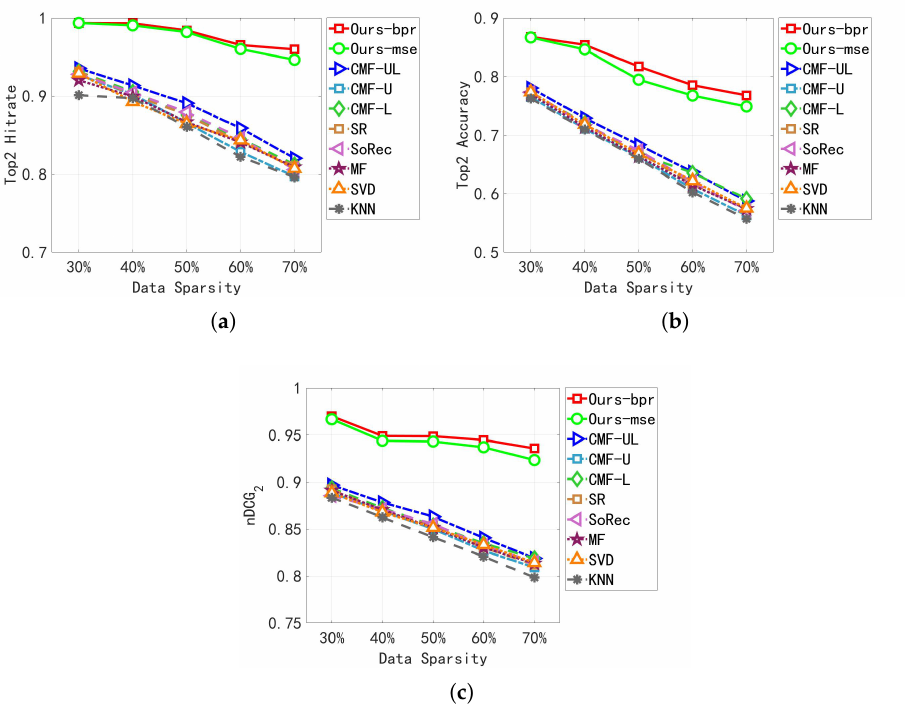
Figure 5. Comparisons of the Recommendation Performances on TalkingData Dataset under Different Sparsity Levels. ( a ) Top 2 Hitrate . ( b ) Top 2 Accuracy . ( c ) nDCG 2 .